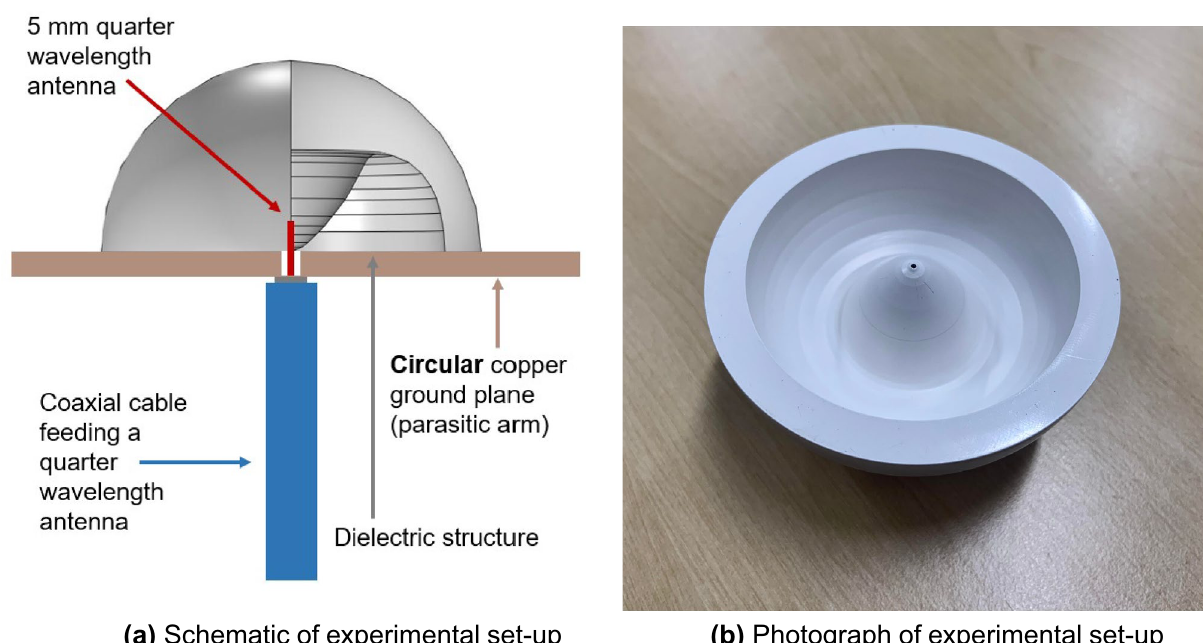
Figure 2. ( a ) A schematic of the experimental set-up, shown on the x-z plane, where the 4.2 cm radius structured dielectric hemisphere of relative permittivity 12 is sat atop a 10 cm radius circular copper ground plane, with a coaxial-fed 0.5 cm grounded quarter-wavelength emitter feeding up through the center, and ( b ) a photograph of said experimental set-up.